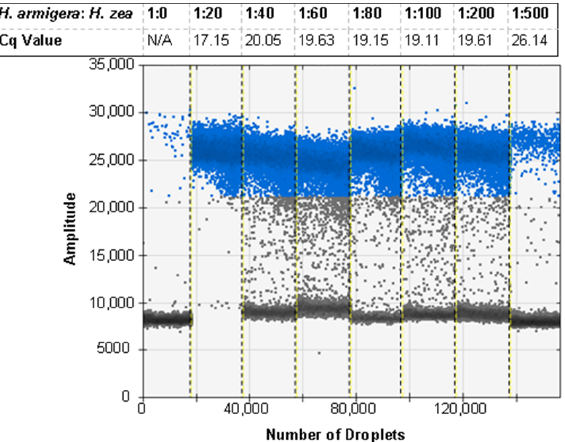
Figure 5. The ddPCR assay using EvaGreen is specific to H. armigera and can detect a single H. armigera leg in up to 500 H. zea legs. Cq values correspond to Table 4. Positive droplets are shown in blue, and negative droplets are shown in grey.